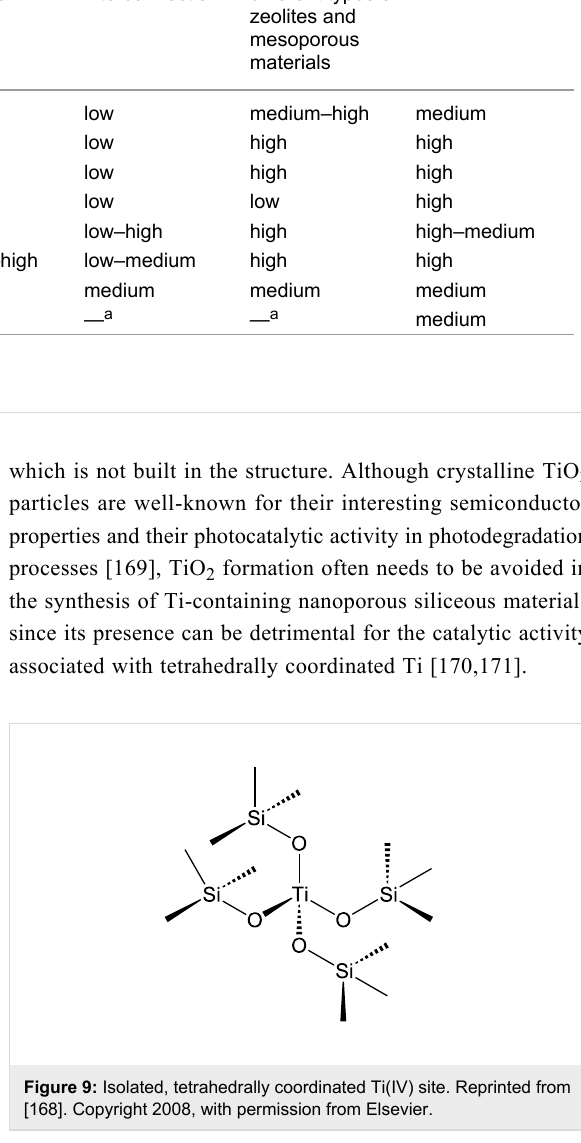
Table 3: Comparison of the feasibility of the most important strategies for the synthesis of combined zeolitic/mesoporous materials (based on all the references used in this review). approach